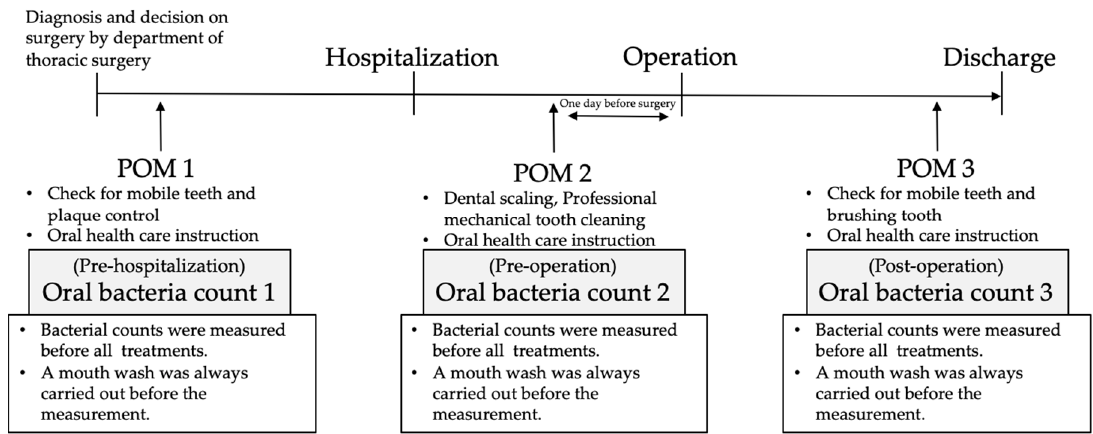
Figure 1. Flow diagram of oral bacteria counts and perioperative oral management (POM).